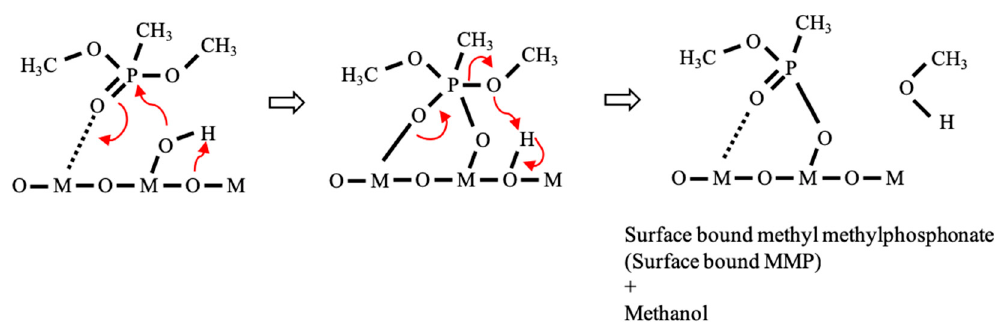
Figure 5. A mechanism of reactive DMMP adsorption on metal-oxide surface via an electrophilic attack of the surface on DMMP molecule [10] .